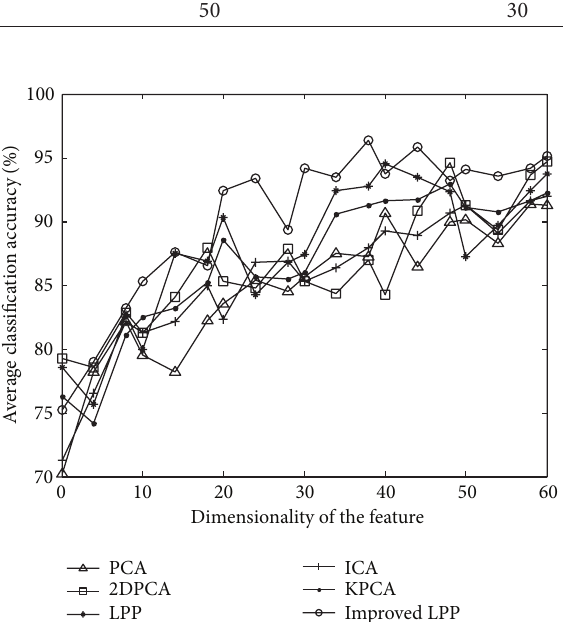
Figure 3: Classification result of data from pakchoi